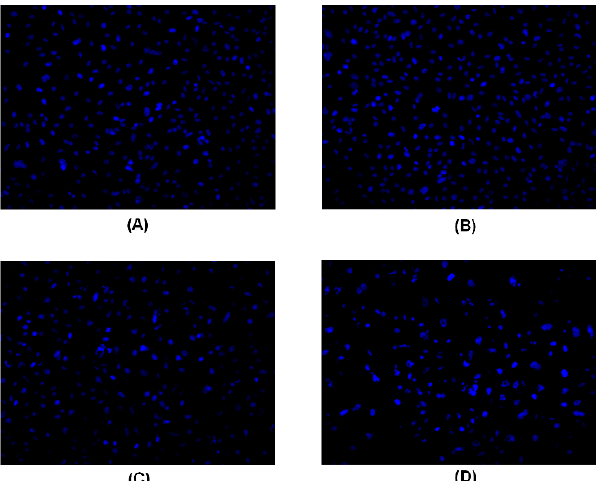
Figure 3. PC-3 cancer cells treated with peperomin E for 72 h with the indicated concentration by Hoechst 33258 staining. A , Control; B , 10 µg/mL peperomin E; C , 30 µg/mL peperomin E; D , 50 µg/mL peperomin E.